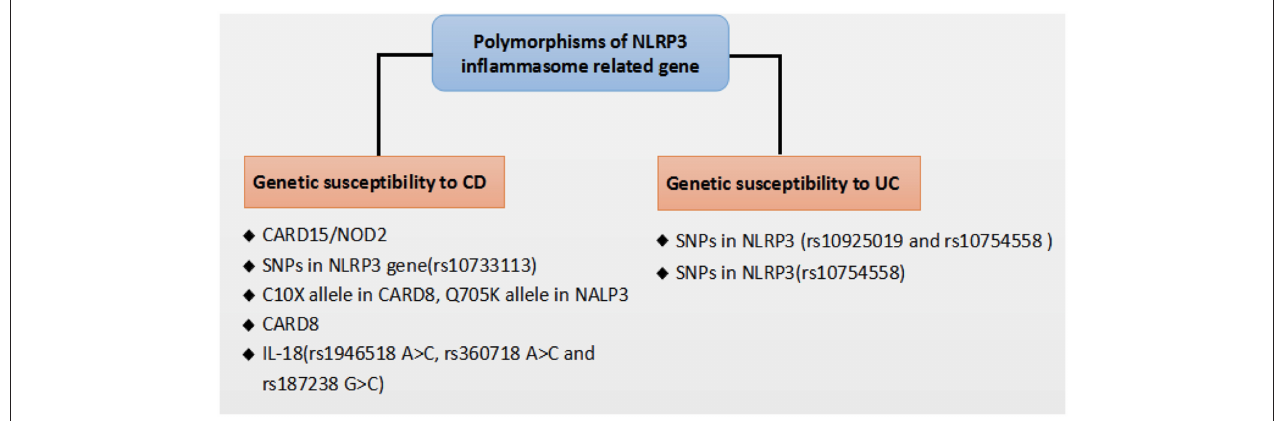
FIGURE 2 | Polymorphisms of NLRP3 inflammasome related gene that affect genetic susceptibility to